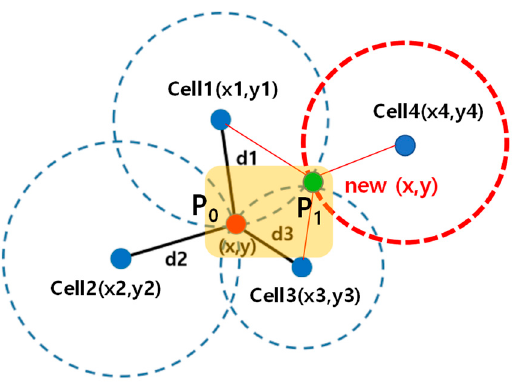
Figure 11. Example movement within a certain bound and the change of positioning result.